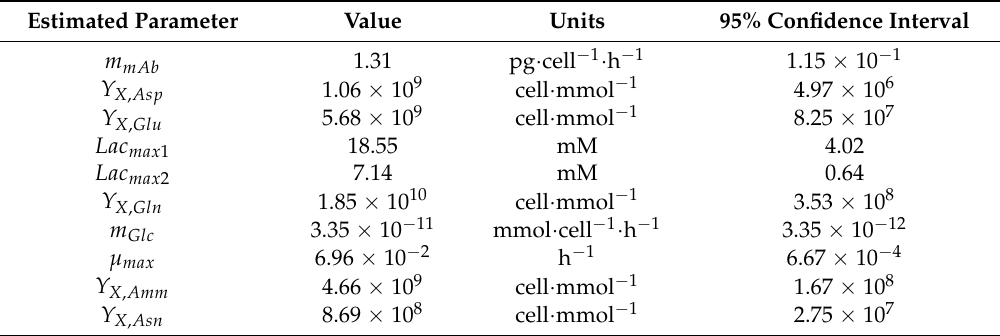
Table 4. Estimated parameters for model adaption to GS46 cell